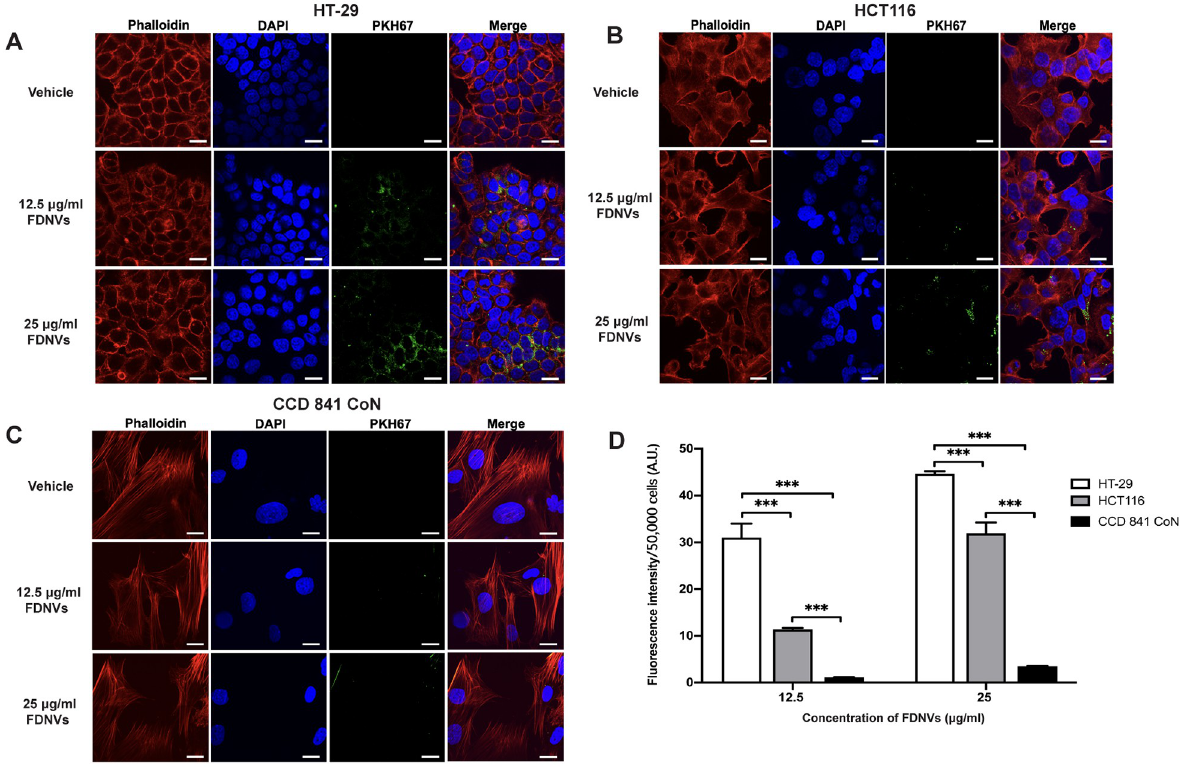
Fig 3. Internalization of FDNVs in colorectal cancer and normal colon epithelial cells. (A) HT-29, (B) HCT116, and (C) CCD 841 CoN cells were incubated with PKH67-labeled FDNVs (green) for 24 h. Cells were also stained with DAPI (blue) and Phalloidin (red) to label the nucleus and actin filaments, respectively. (D) The green fluorescence intensity of FDNVs was determined using ImageJ software. The values are shown as means ± SD of three independent experiments in duplicate. ��� P < 0.001 (one-way ANOVA). Scale bar = 10 μ m.